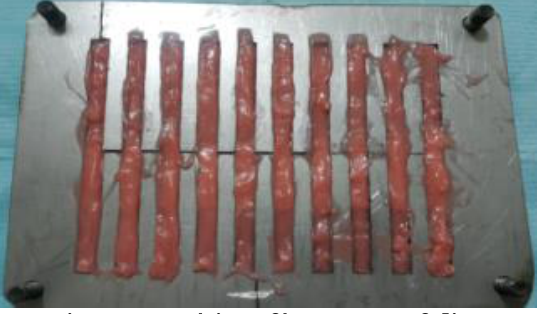
Figure 5: Packing of heat cure soft